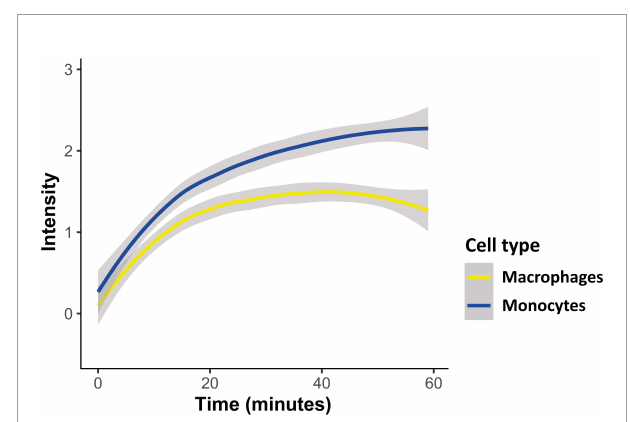
FIGURE 2 | Kinetic measurement of Pf -derived EV uptake into either monocytes or macrophages using IFC. Pf -derived EVs were labeled by Thiazole orange (TO), and their uptake into monocytes (THP-1 cells) or macrophages (differentiated from THP-1 cells) was measured for 1 hour. Graph representing the signal modi fi cation in TO intensity that was detected over time originating from monocytes and macrophages recipient cells. Graph representing at least three independent biological replicates. Cell types were compared with a linear mixed effects model, with cell type and time as fi xed factors, and sample ID as a random factor. Statistics were done in R, v. 4.0.4, using the package ‘ lmerTest ’ . Grey area around the lines represents 95% con fi dence intervals,